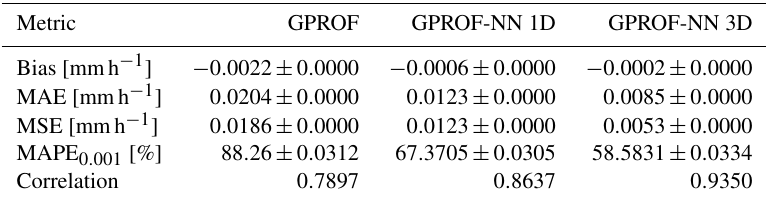
Table C3. The same as Table 4 but for